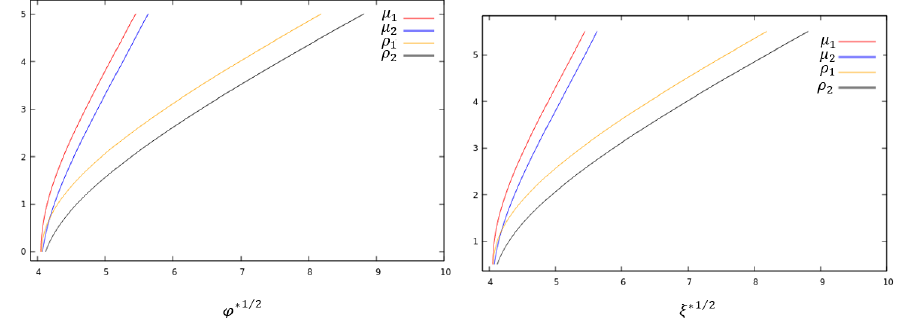
Figure 3. We show the values of the chemical potentials µ i and charge densities ρ i , i = 1,2, re- spectively, as functions of the condensate value ϕ + ( left ) and ξ + ( right ) for the unbalanced, non- interacting case.